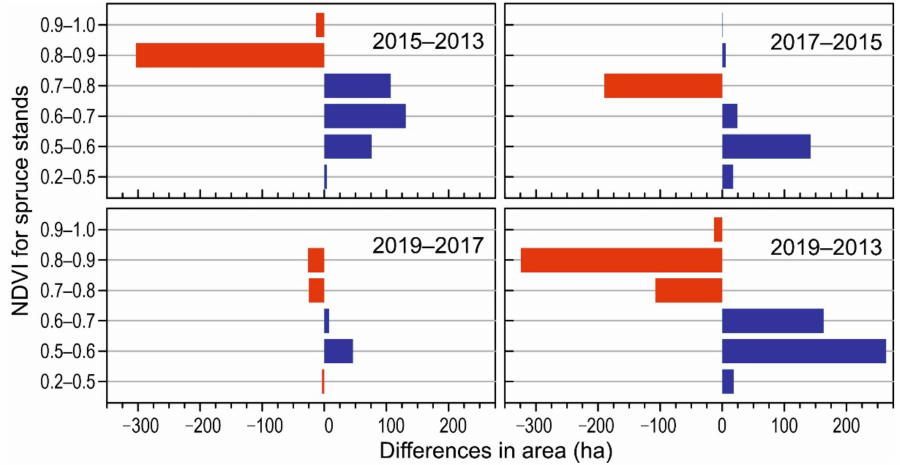
Figure 6. Differences in the area of the NDVI classes of the studied spruce